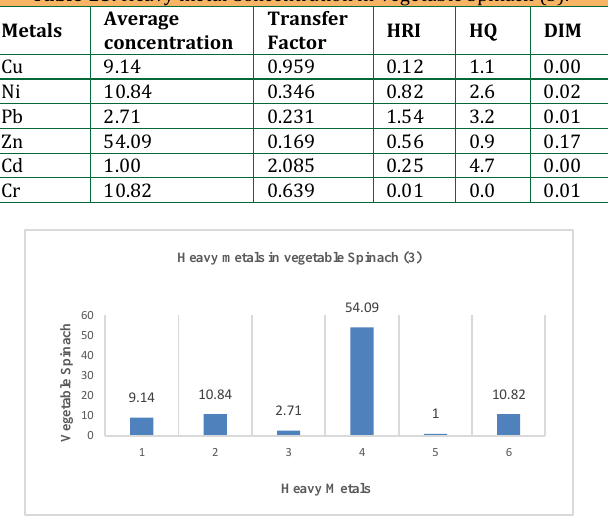
Figure 15: Average Concentration in vegetable Spinach